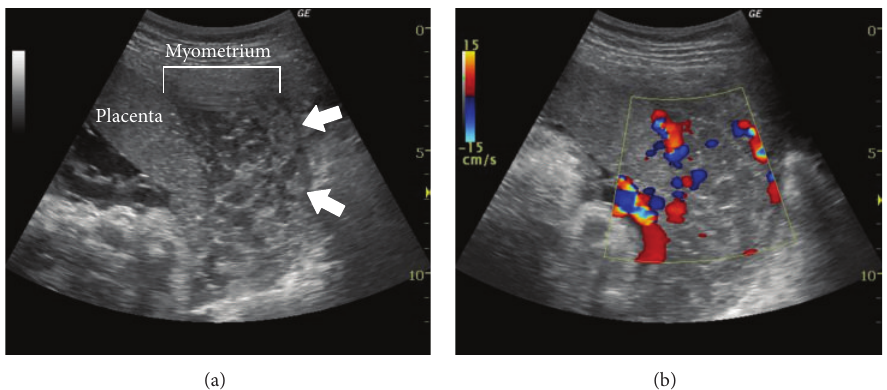
Figure 2: Ultrasonography demonstrated tubular echolucent spaces throughout the myometrium (a), and color Doppler showed blood flow within some of the cystic lesions (b) at 27 weeks of gestation.